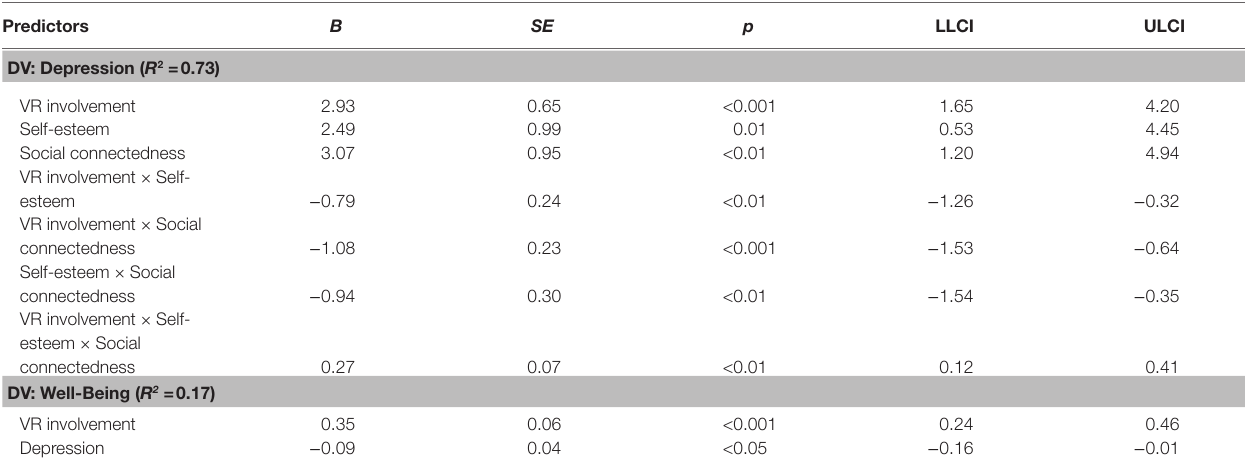
TABLE 2 | Path estimates.